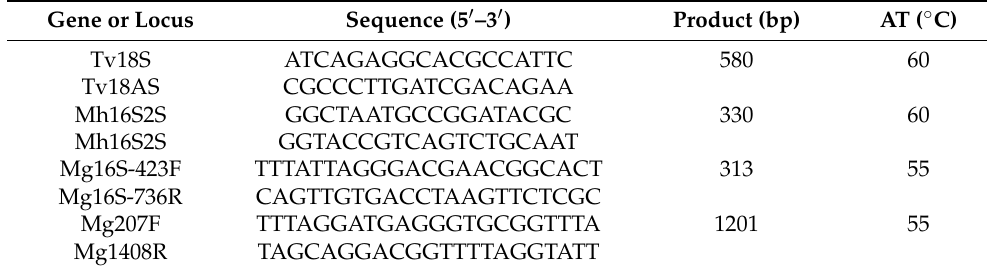
Table 1. Primers used in this